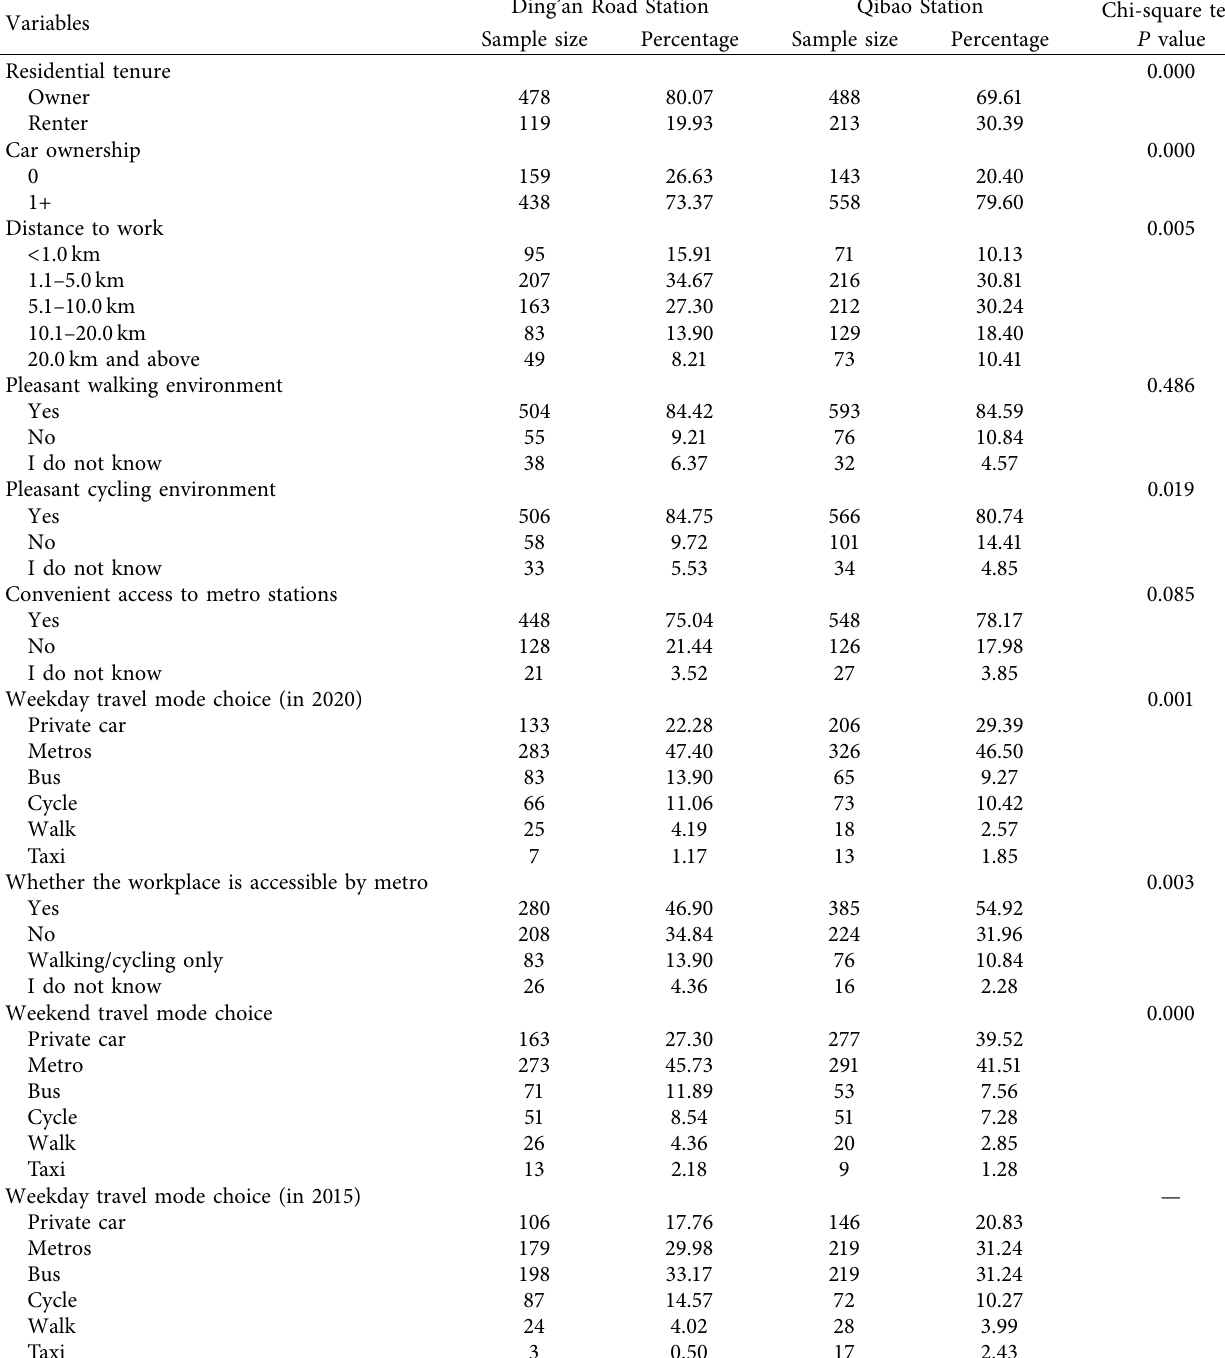
Table 3: Descriptive statistics and summary test statistics (chi-squared